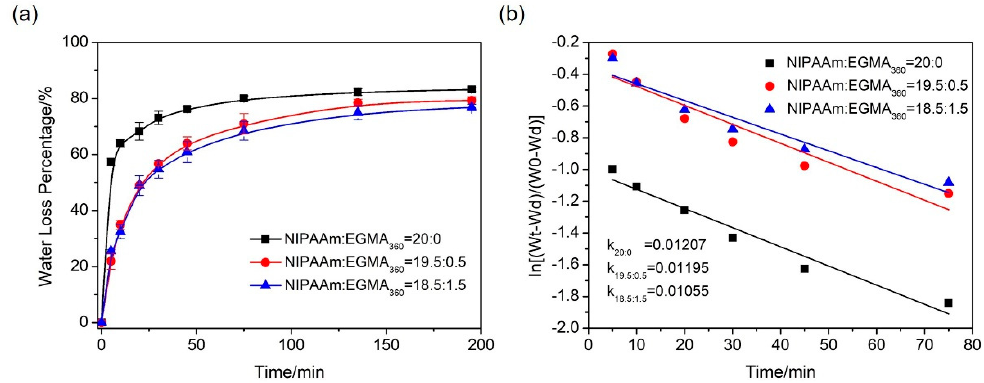
Figure 10. ( a ) Deswelling kinetics of alginate-Ca 2+ /P(NIPAAm- co -EGMA 360 ) hydrogel in water at 45 °C from the equilibrium swelling state at 25 °C. ( b ) Rate analysis of the deswelling properties of the corresponding hydrogels. The monomer ratios of NIPAAm to EGMA 360 are 20:0, 19.5:0.5, and 18.5:1.5. To quantitatively analyze the deswelling behavior, a semi-logarithmic plot as a first ordered rate analysis was applied to the time dependence deswelling kinetics analysis